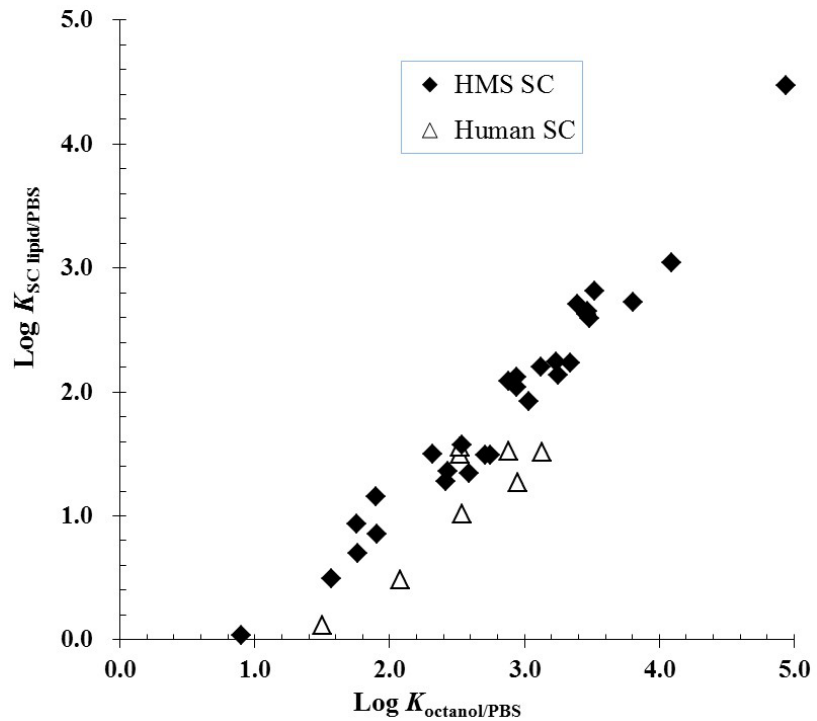
Figure 3. Relationship between K (the intercellular lipid/PBS partition coefficients) SC lipid/PBS of the enhancers and K (the enhancer n-octanol/PBS partition coefficients) in octanol/PBS hairless mouse skin stratum corneum (HMS SC) and human stratum corneum (human SC). The data are taken from previous hairless mouse skin (HMS) and human